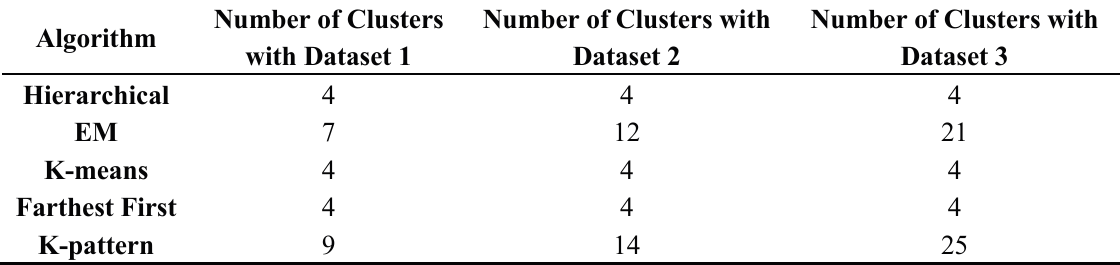
Table 4. Number of clusters formed using different